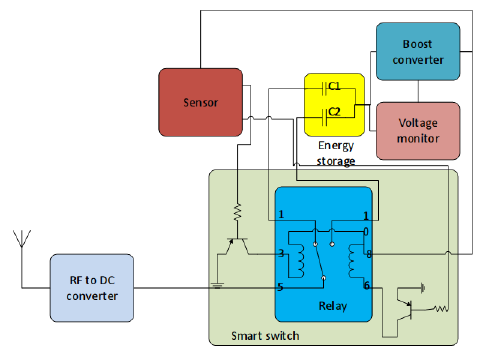
Figure 3. Smart switching circuit for